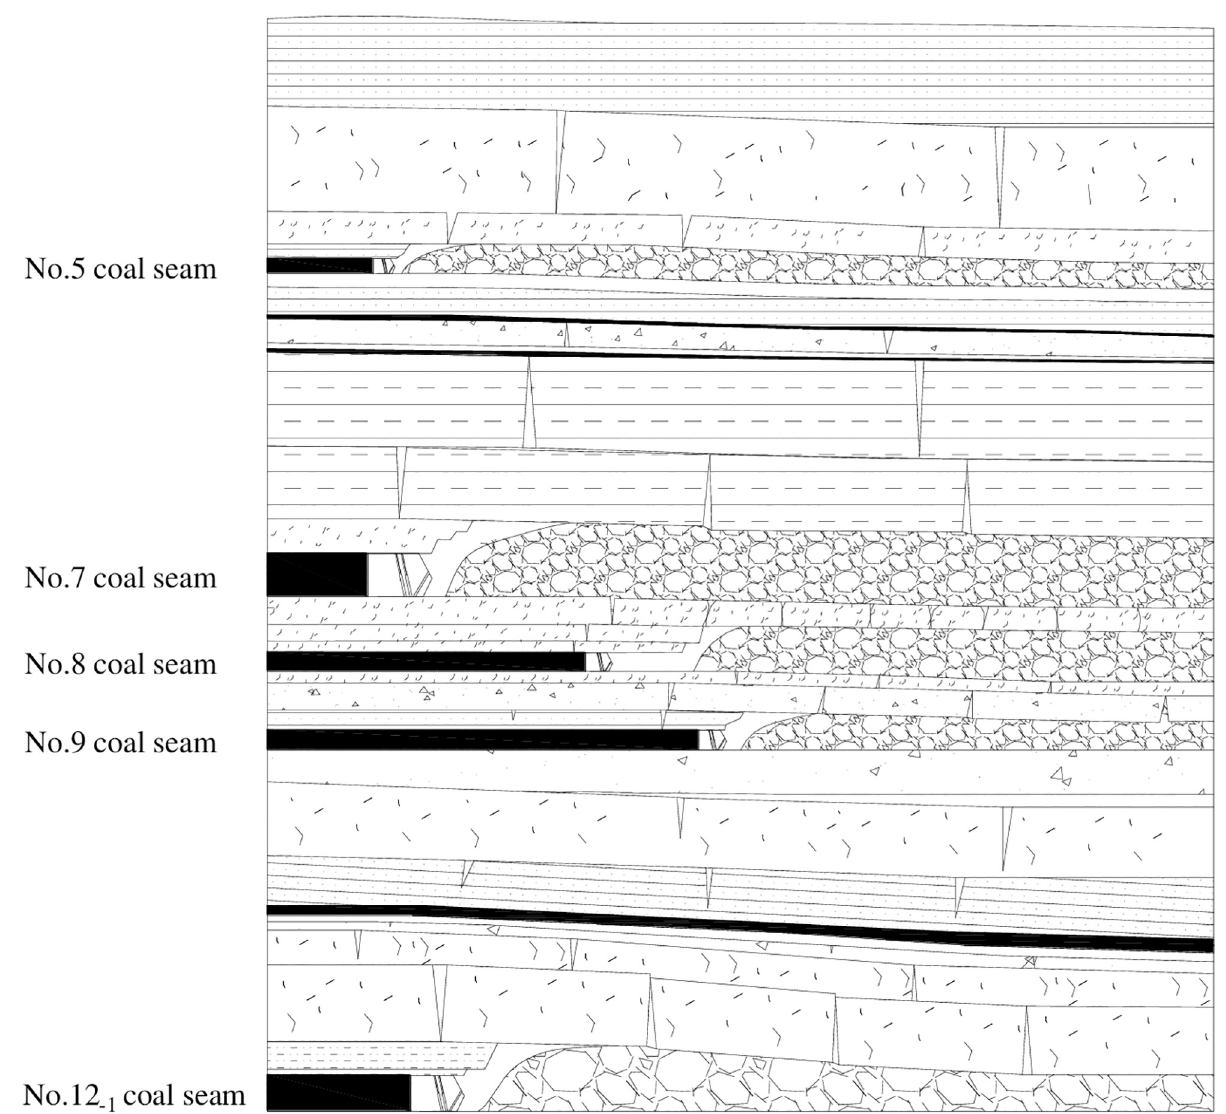
Fig 7. Roof structure model of full-cover rock strata (modified according to